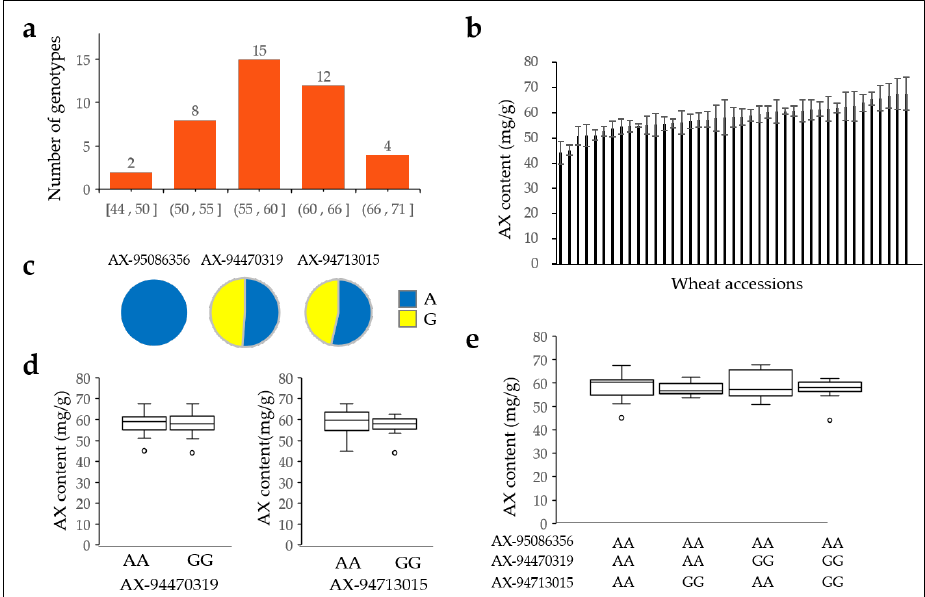
Figure 8. The AX content in 41 Republic of Korea cultivars. Distribution of AX content in 41 Republic of Korea cultivars ( a , b ), adenine and guanine allele rates in AX–95086356, AX–9447319, and AX– 94713015 ( c ), AX content in AX-94470319 and AX-94713015 alleles ( d ), and combination of AX– 95086356, AX-94470319, and AX-94713015 alleles ( e ). The number on the bar indicates the number of genotypes.